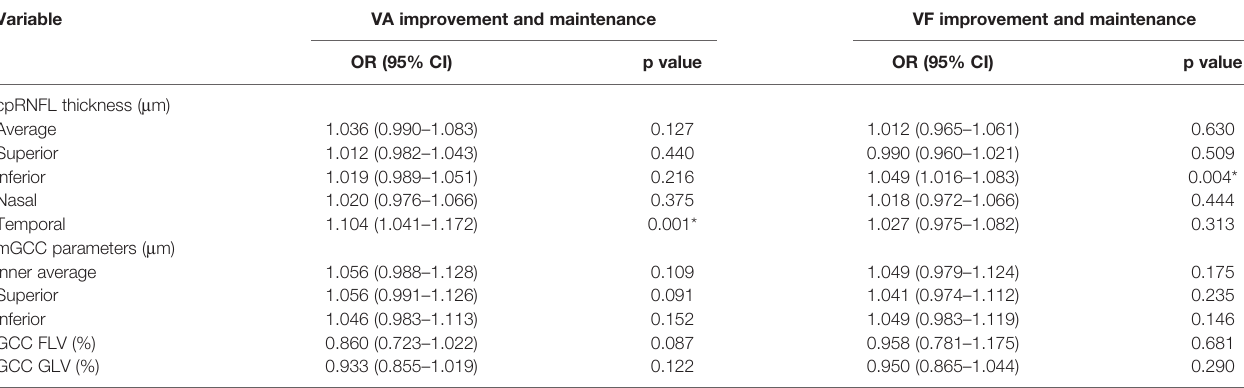
TABLE 3 | Univariate logistic regression for visual improvement and maintenance by OCT